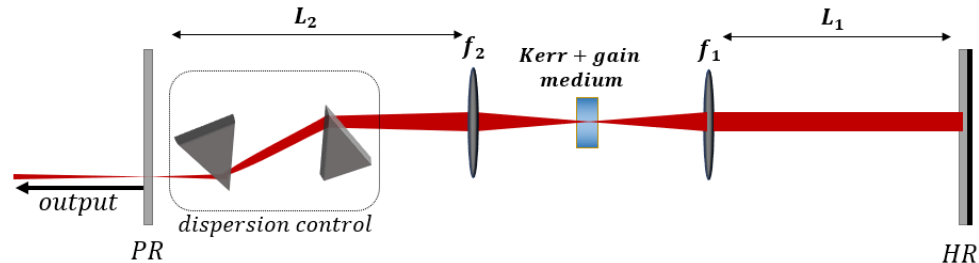
Figure 1. The cavity layout of a standard KLM laser in a linear cavity: The cavity focus is formed by two spherical mirrors/lenses, where the nonlinear Kerr medium (and gain) is placed. Two cavity arms of lengths L 1 , L 2 exist around the focus. One of the arms includes components for tuned dispersion control (e.g., a